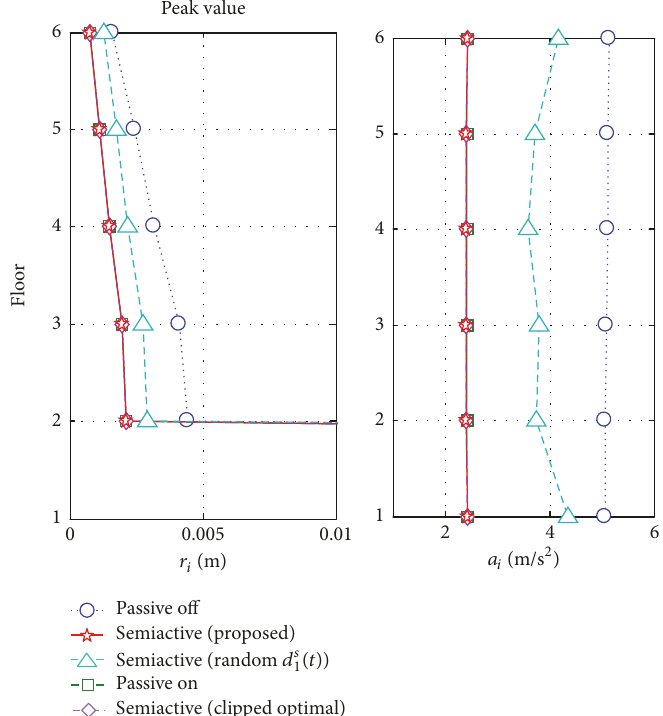
Figure 14: Simulation results for the Hachinohe NS (1968) earthquake disturbance; peak values of the relative displacement between neighboring floors and absolute acceleration of each floor.